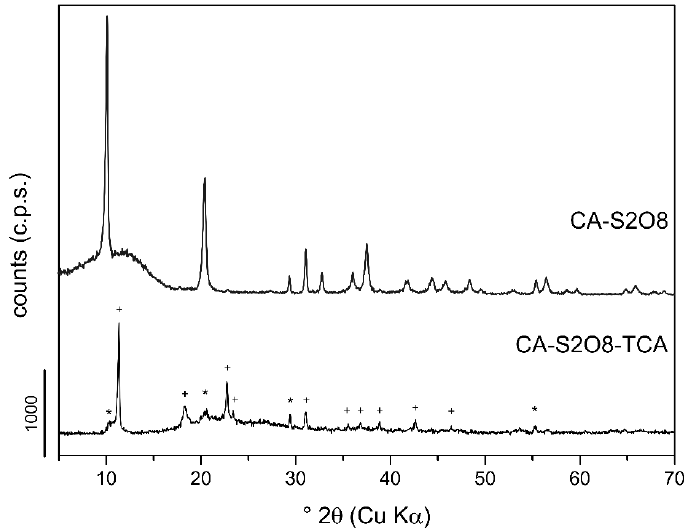
Figure 9. PXRD pattern of the reacted sample CA–S2O8 after experiments using 1,1,2-TCA ( bottom ) compared to the pattern of the unreacted raw material ( top ). Peaks were labelled regarding their assigned mineral phases; ( + ) hydrocalumite and (*) kuzelite.